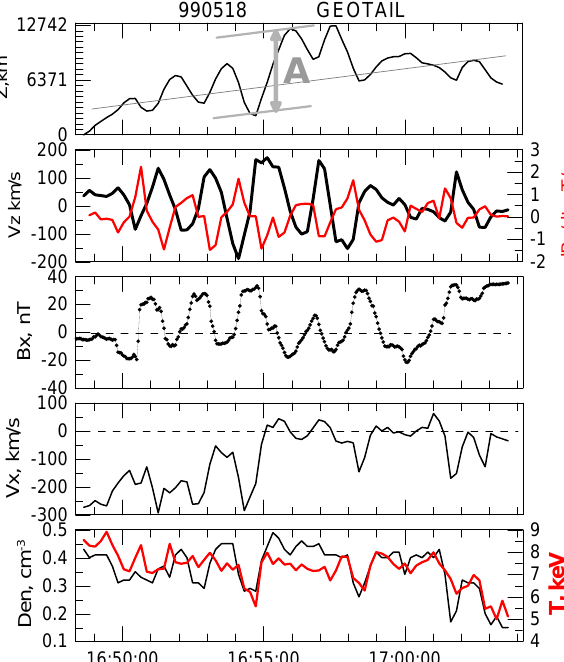
Fig. 9. Distributions of maximal amplitude of the vertical sheet motion and of its apparent thickness, as well as of their ratio in 26 sequences of flapping